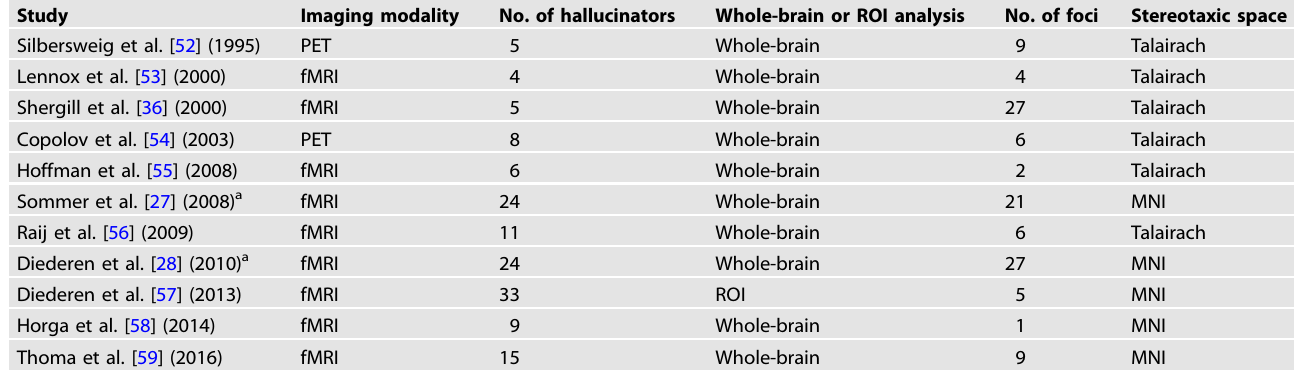
Table 1. The characteristics of the state studies included in the